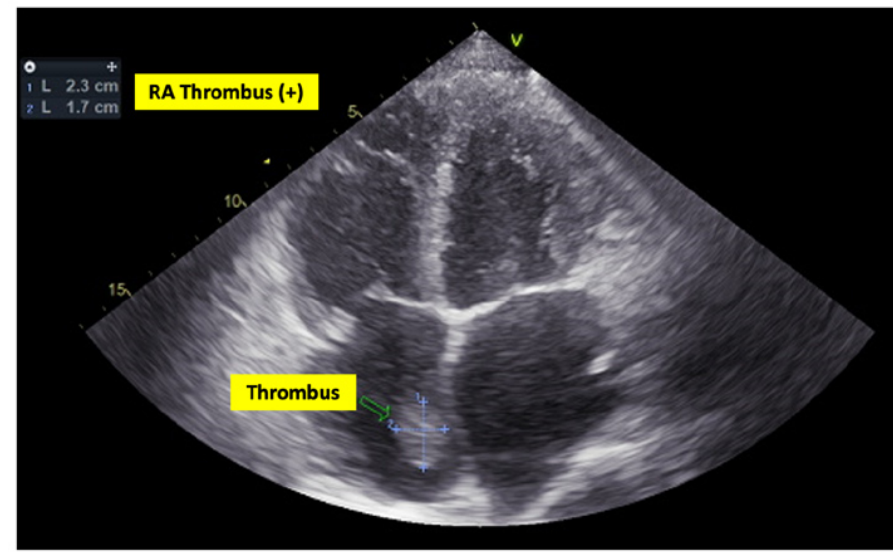
Figure 3. Transthoracic echocardiogram (TTE) showing thrombus in the right atrium. RA = right